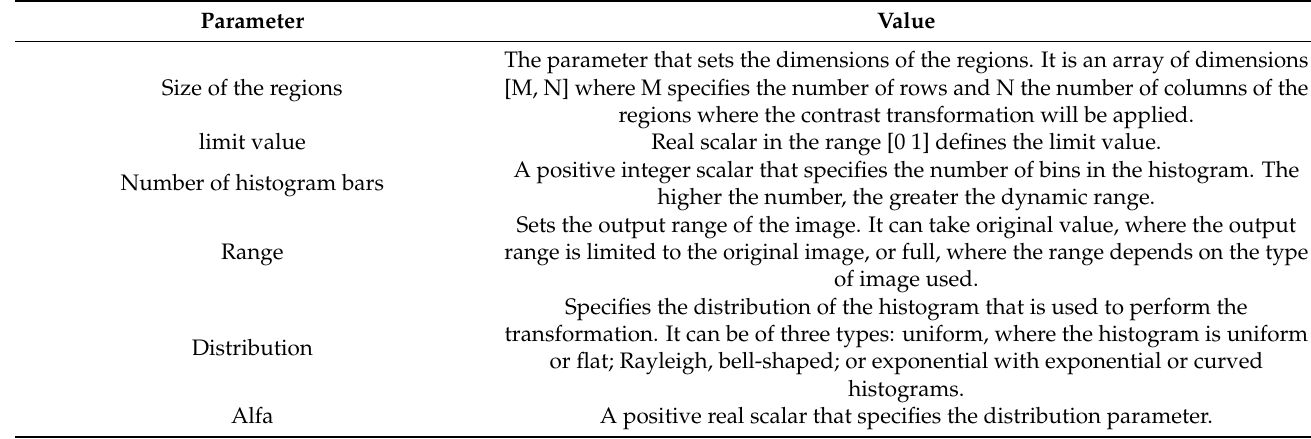
Table 3. Modifiable parameters in the